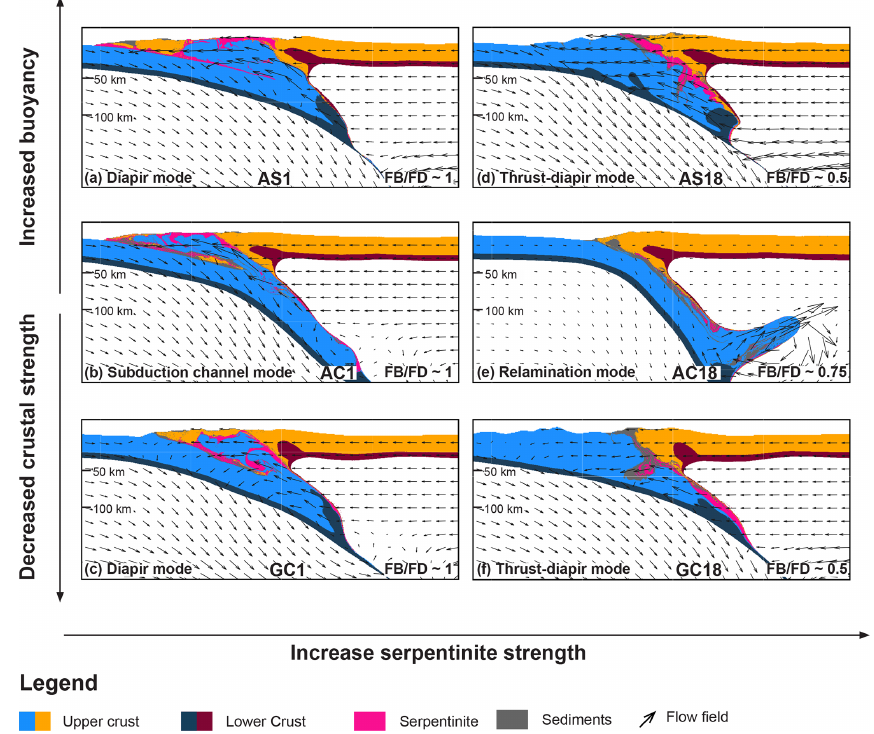
Figure 12. Orogen dynamics observed in the models presented here. Light blue and orange indicates the upper crustal phases, dark blue and merlot red indicates the lower crustal phases of the subducting and upper plates, respectively. Dark grey and magenta represent the sediments and the serpentinite unit, respectively. Arrows indicate the velocity field calculated by the numerical algorithm.